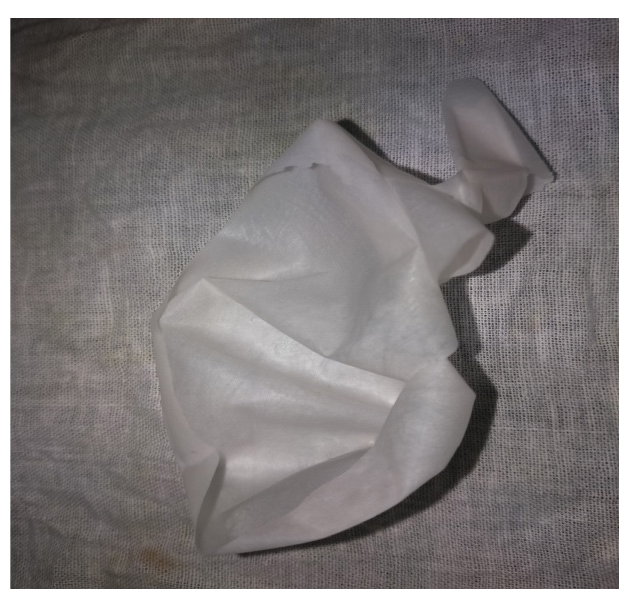
FIGURE 2 - Semipermeable membrane.